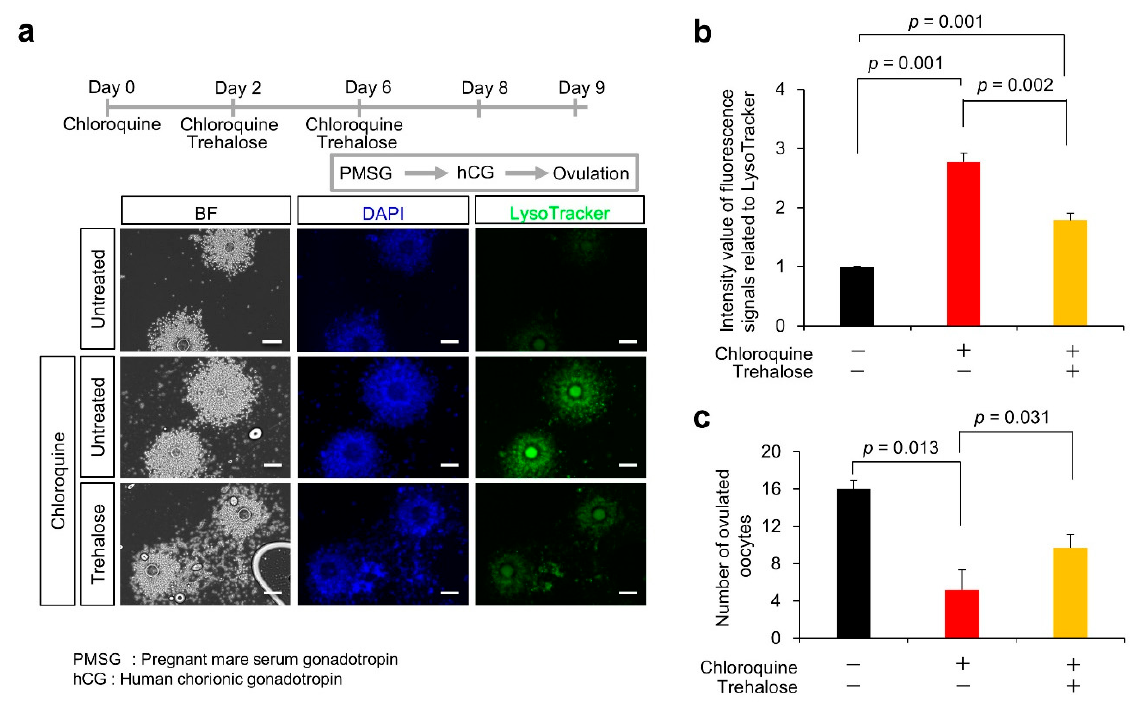
Figure 5. Partial rescue of decrease in chloroquine-induced ovulated oocytes number through trehalose treatment. ( a ) Experimental flow. As depicted in ( a ), chloroquine alone or in combination with trehalose was injected into 7-week-old female mice (each group: n = 5). To examine the lysosomal distribution, cells were stained with LysoTracker Green DND26 (green). Scale bars, 100 µ m. ( b ) Quantification of fluorescent intensities of lysosomes (over 200 cells were counted in each case). The signal intensity in COC without chloroquine or trehalose treatment (black bar) was arbitrarily set at 1. The graph (red bar; chloroquine alone, yellow bar; in combination with trehalose) indicates the relative intensity value of fluorescence signals related to LysoTracker against that in COC without chloroquine or trehalose treatment (black bar). ( c ) Number of ovulated oocytes after chloroquine alone (red bar) or in combination with trehalose (yellow bar). Black bar indicates number of ovulated oocytes without chloroquine or trehalose treatment. Ovulated oocytes were collected from the superovulation-induced female with and without chloroquine and metaphase II-arrested oocytes were counted. Values are expressed as the mean ± SE.